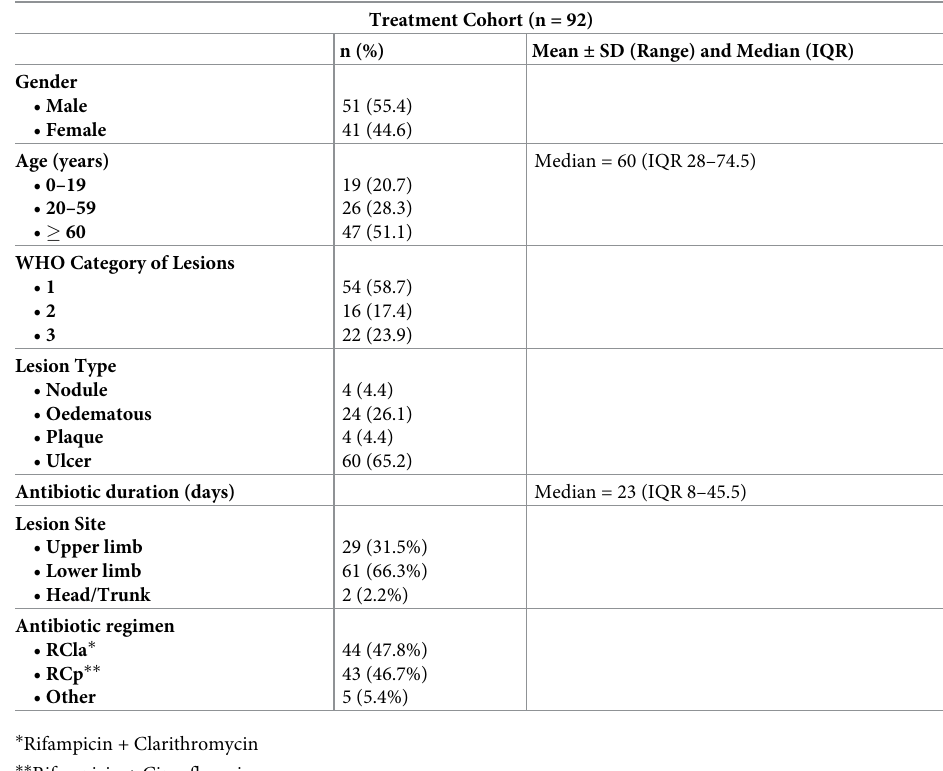
Table 1. Baseline cohort